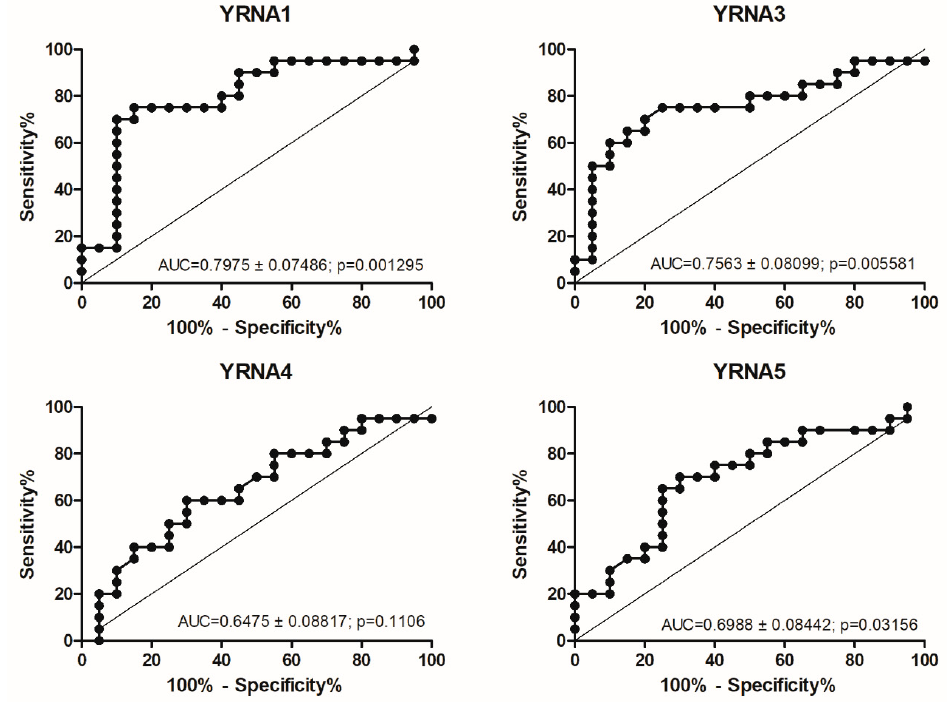
Figure 4. Receiver operating characteristic (ROC) analysis of YRNA1, YRNA3, YRNA4 and YRNA5.